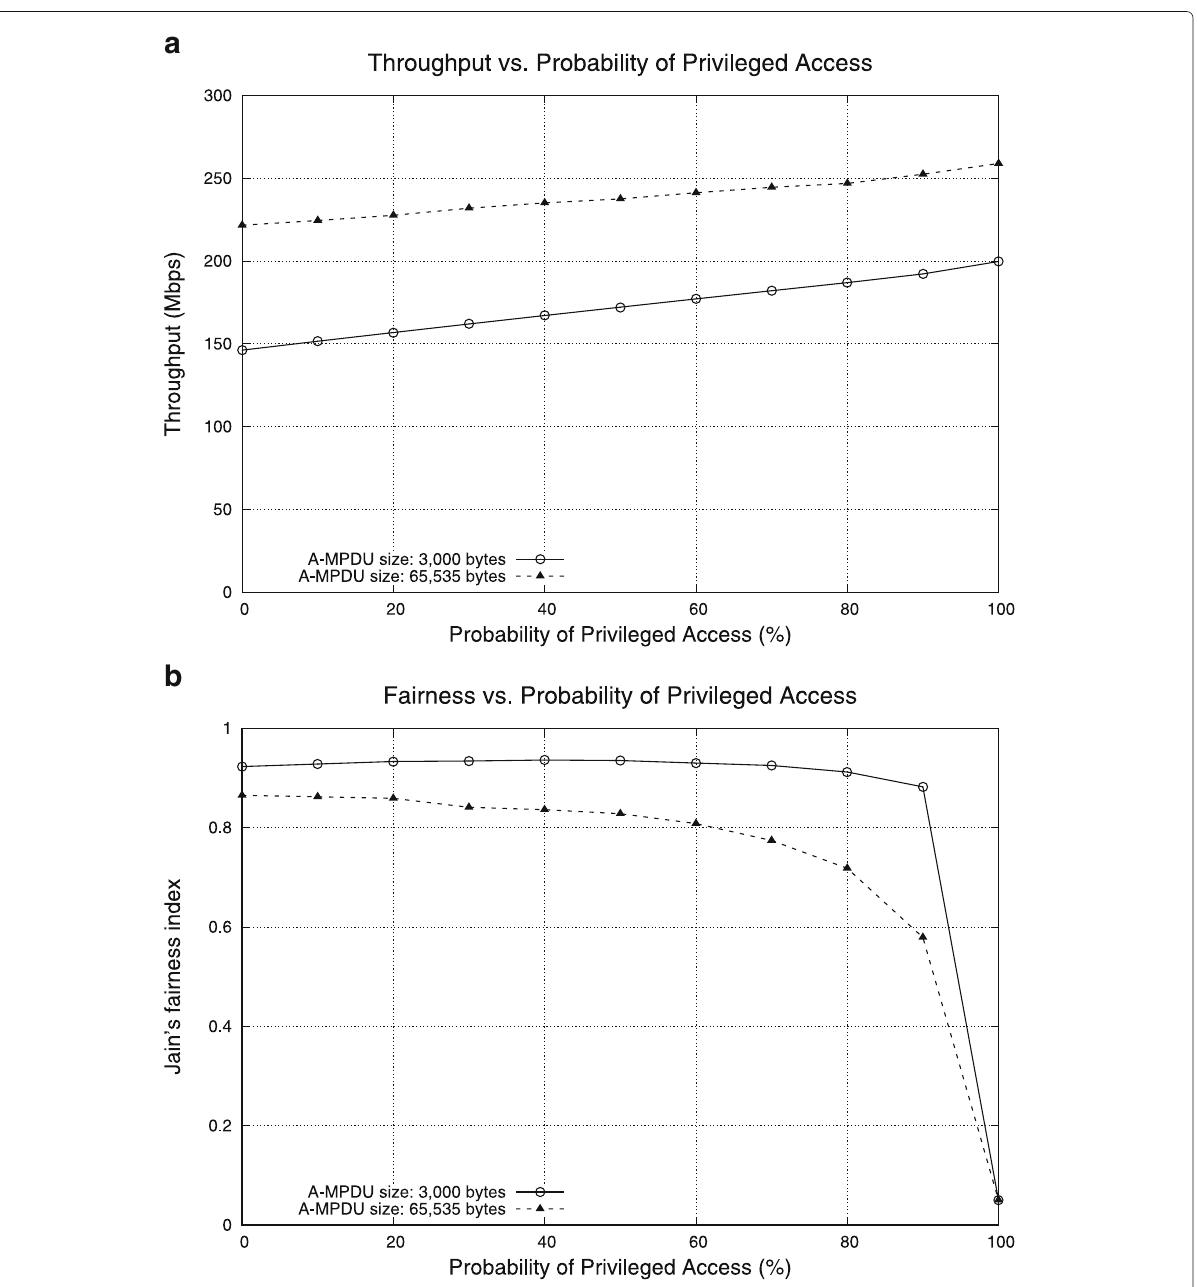
Fig. 14 Average throughput and Jain’s fairness index varying probability of privileged access. a Throughput. b Fairness